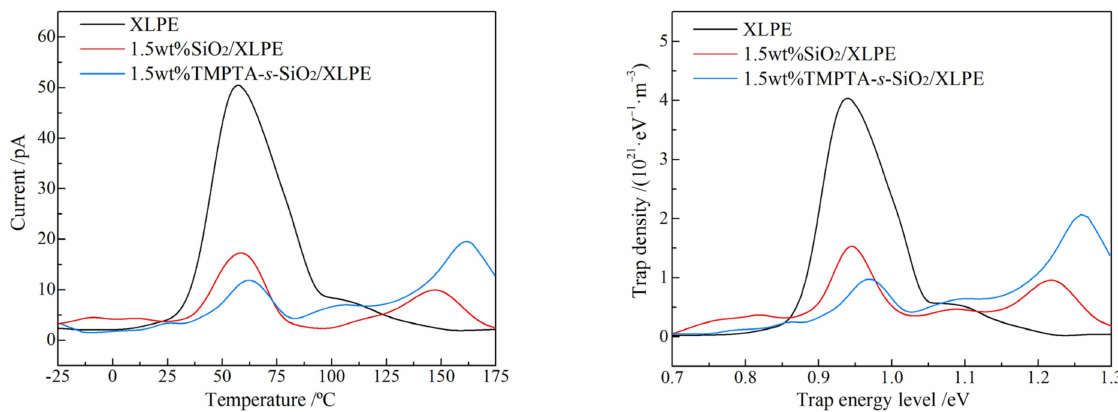
Figure 9. Thermally stimulated current (TSC) temperature spectra ( left ) and trap energy level distributions ( right ) of pure XLPE and the XLPE nanocomposites filled with TMPTA- s -SiO 2 and neat SiO 2 nanoparticles,